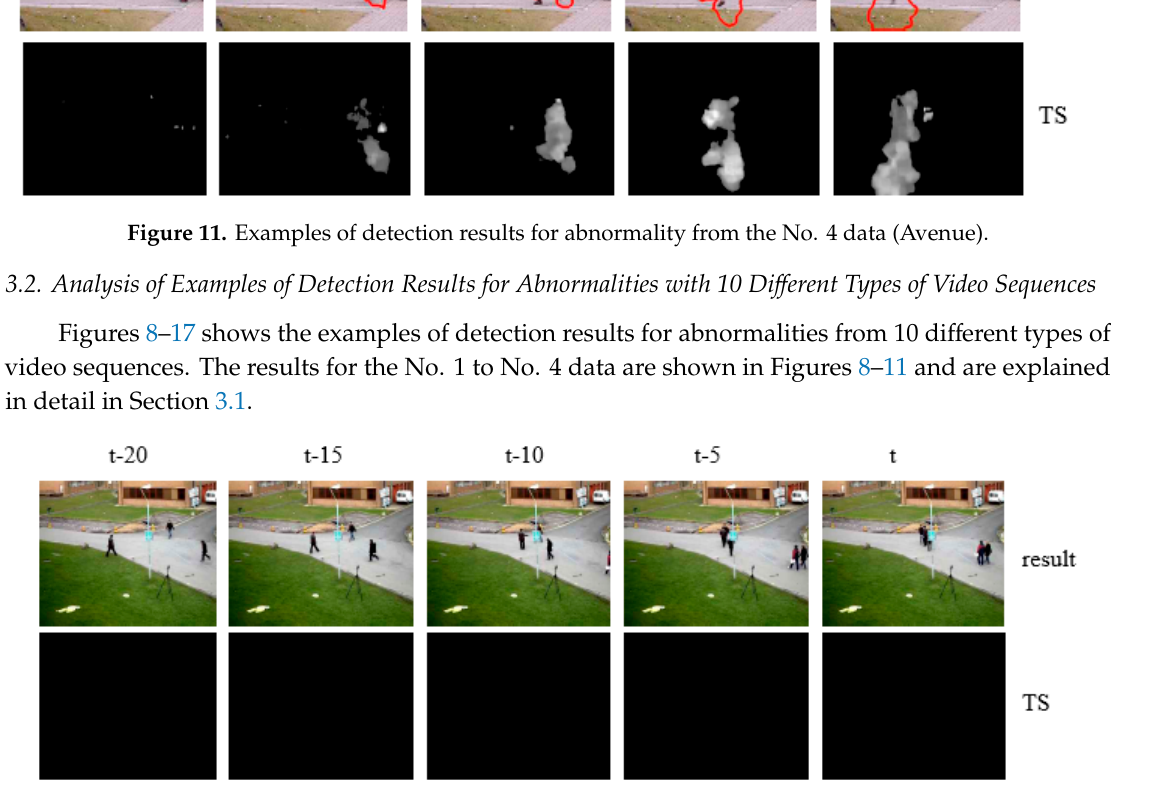
Table 3. AUC(area under the curve) comparison with state-of-the art methods on the Avenue dataset.